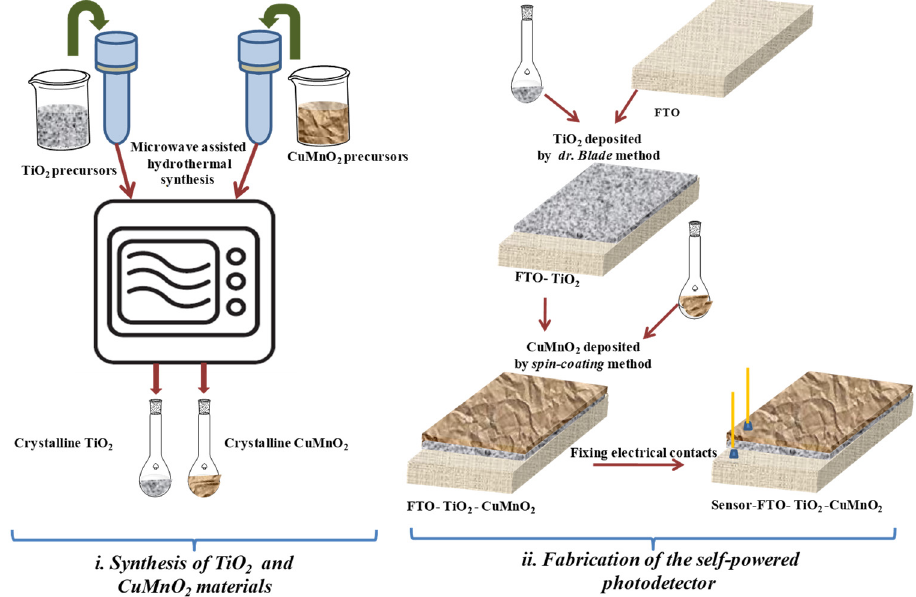
Figure 1. Schematic illustration of self-powered photodetector fabrication.